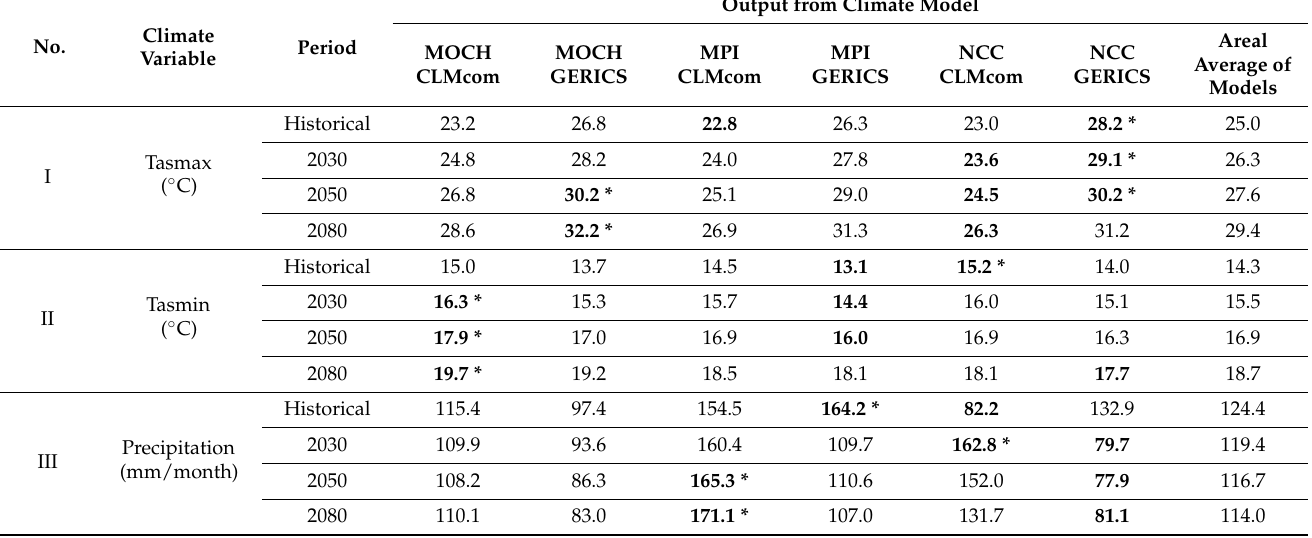
Table 3. Computed results of the multi-model ensemble projections for minimum temperature ( ◦ C), maximum temperature ( ◦ C), and precipitation (mm) in the future time periods, comparing historical (1971–2005), near-term 2030 (2021–2040), mid-term 2050 (2041–2070), and long-term 2080 (2071–2100) data under the RCP8.5 scenario over the urban centers of southwest Ethiopia. The values in bold only indicate the smallest, and bold with * indicate the largest value within the time